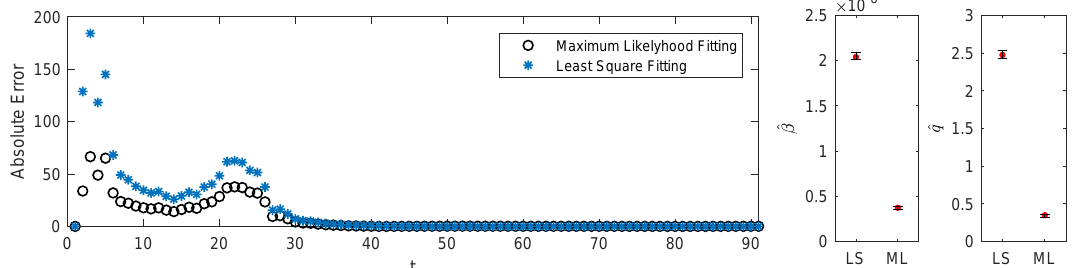
Figure 2. Absolute errors for least squares (LS) and maximum likelihood (ML) methods are shown for daily data in the first figure. Associated estimated parameters with confidence interval are shown on the right side. The red dot is the estimated value and the error bars stands for the 95% confidence interval. The eye ball test tells us that the confidence interval is smaller if estimated by ML